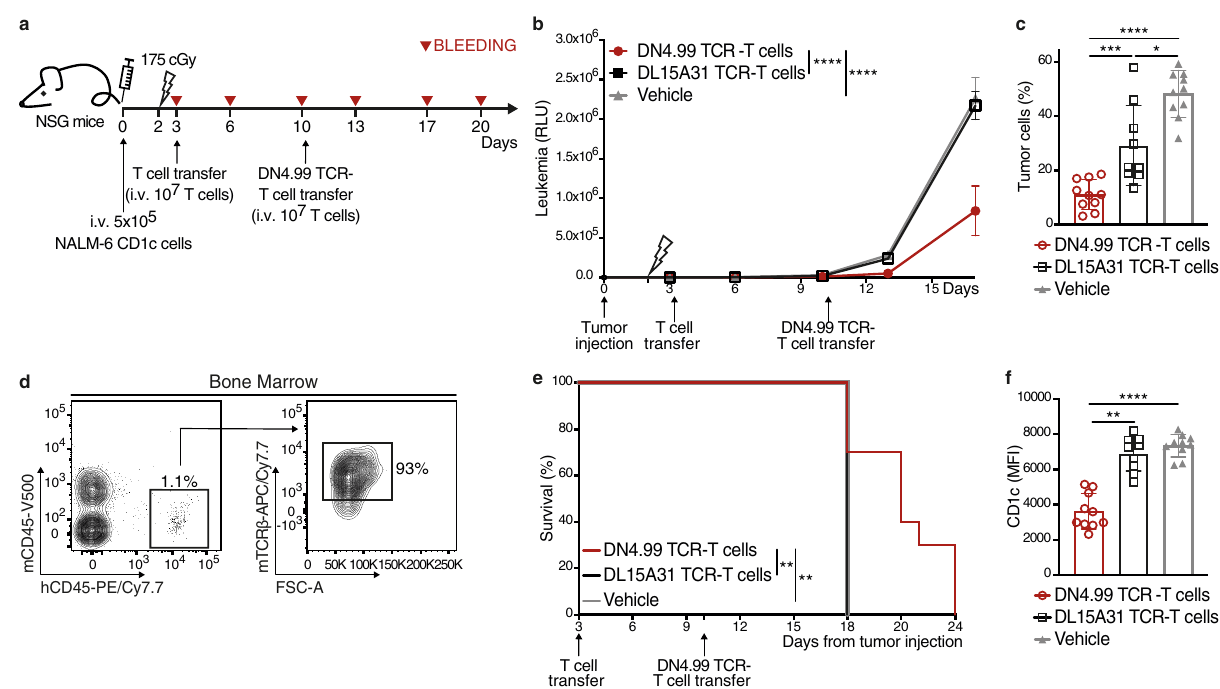
Fig. 8 In vivo anti-leukemia ef fi cacy of DN4.99 TCR-T cells against CD1c + acute leukemia NALM-6. DN4.99 TCR-transduced T (DN4.99 TCR-T) cells restrict NALM-6-CD1c leukemia progression in vivo. a NOD.Cg-Prkdcscid IL- 2rgtm1Wjl/SzJ (NSG) mice ( n = 30) received intravenous (i.v.) injection of 5 × 10 5 NALM-6 CD1c co-expressing secreted LUCIA luciferase. Two days later, the mice were sub-lethally irradiated, followed 24 h later by the transfer of 10 7 primary 70% CD8 + /30% CD4 + DN4.99 TCR-T cells (red lines/dots), control T cells (black line/squares) transduced with the